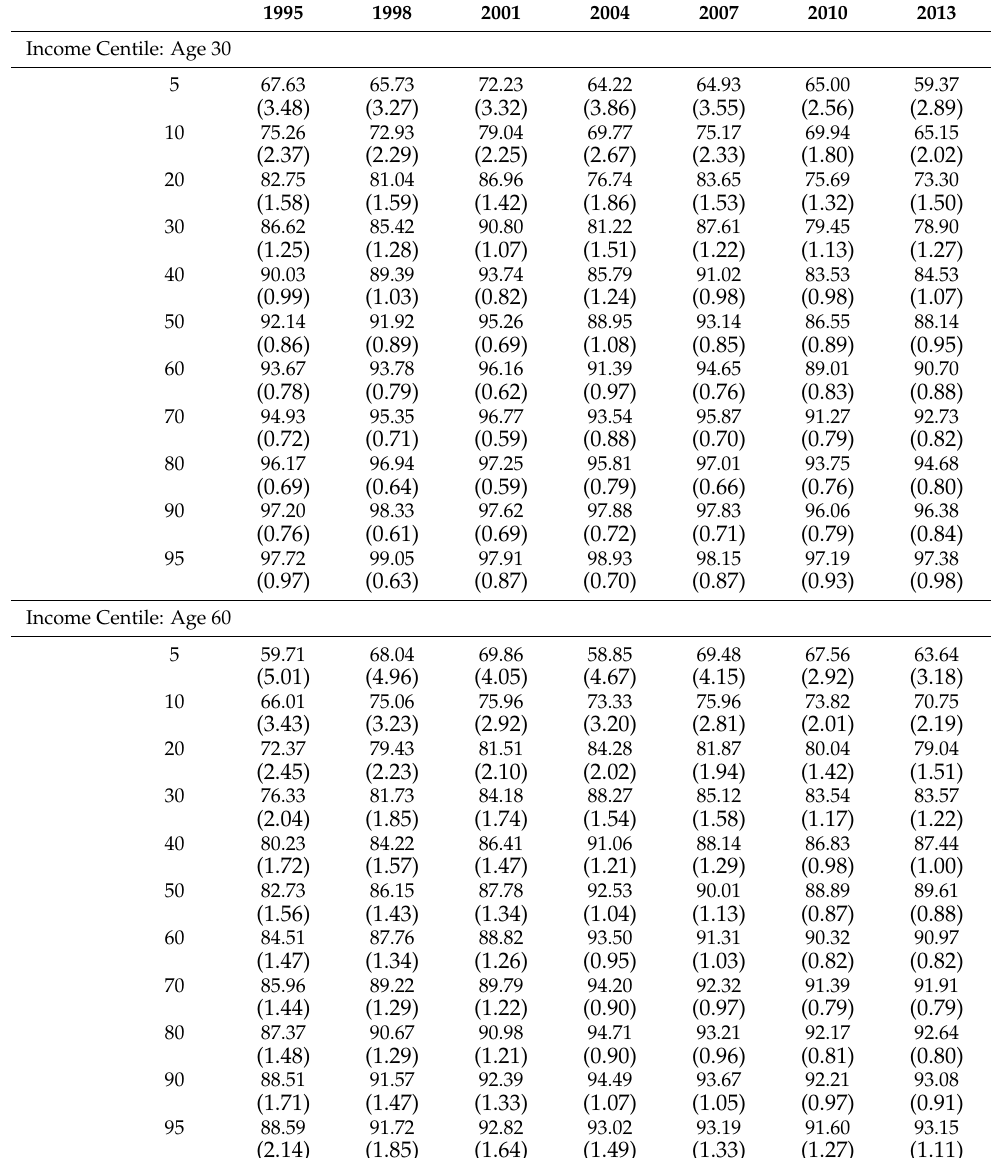
Table A10. Credit Acceptance at Different Income Centiles for Young and